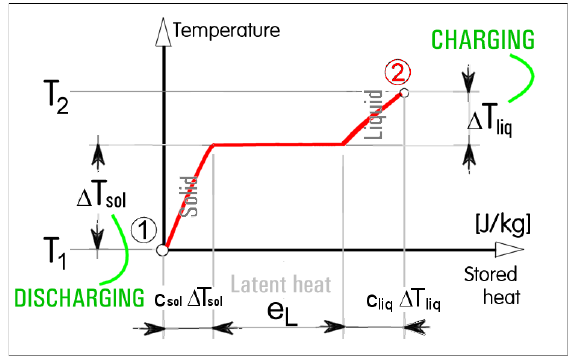
Fig. 7. Ideal loss-less heat storage would follow the constant temperature level as shown here between 1 and 2. Unfortunately, transport of heat to or from the storage body is not possible without temperature differences necessary – Fig. 8 – for charging as well as discharging.